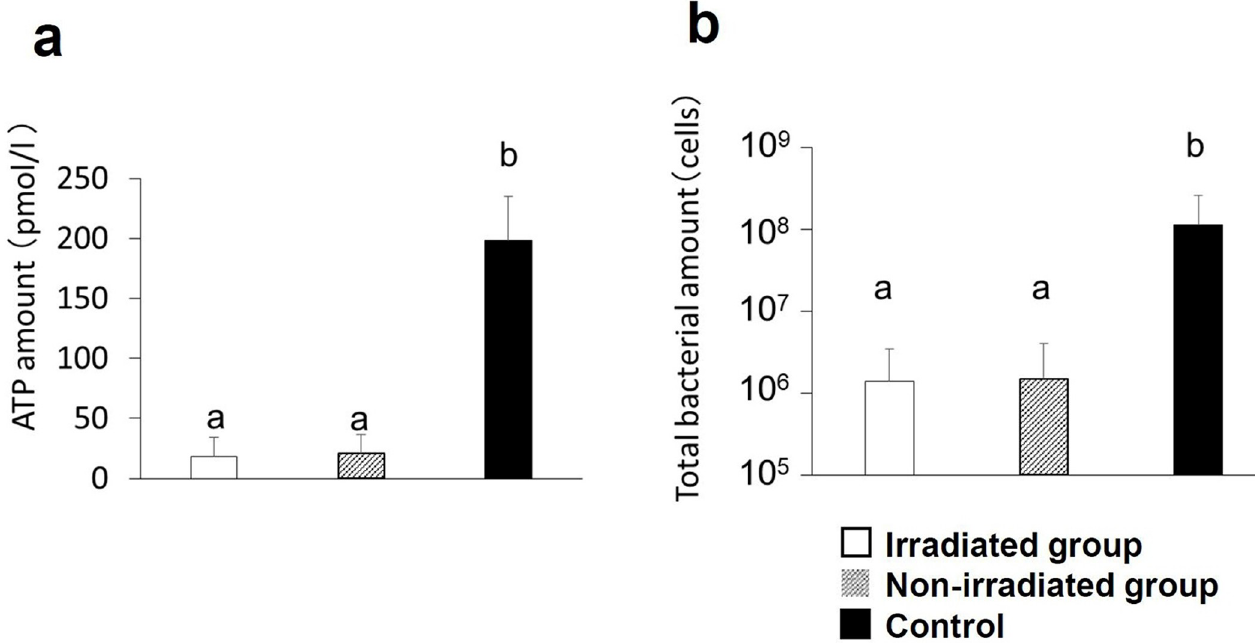
Fig 3. Quantification of bacteria in root canal. a: ATP level (number of live bacteria) in root canal immediately after root canal treatment (RCT). b: Total number of bacteria in root canal after RCT.